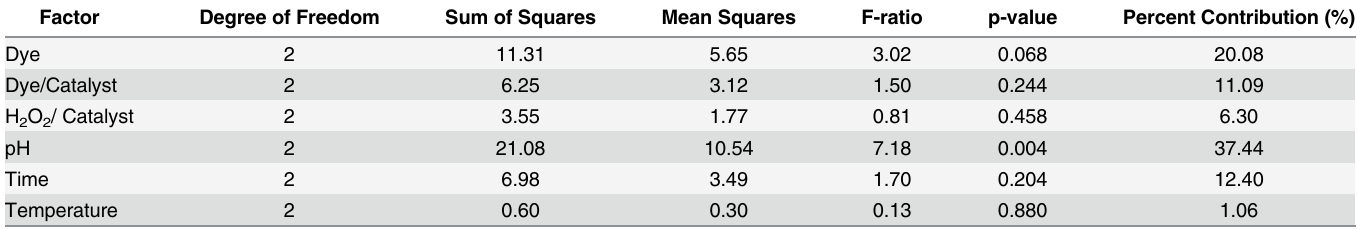
Table 12. ANOVA analysis. Factor Degree of Freedom Sum of Squares Mean Squares F-ratio p-value Percent Contribution (%) Dye Dye/Catalyst